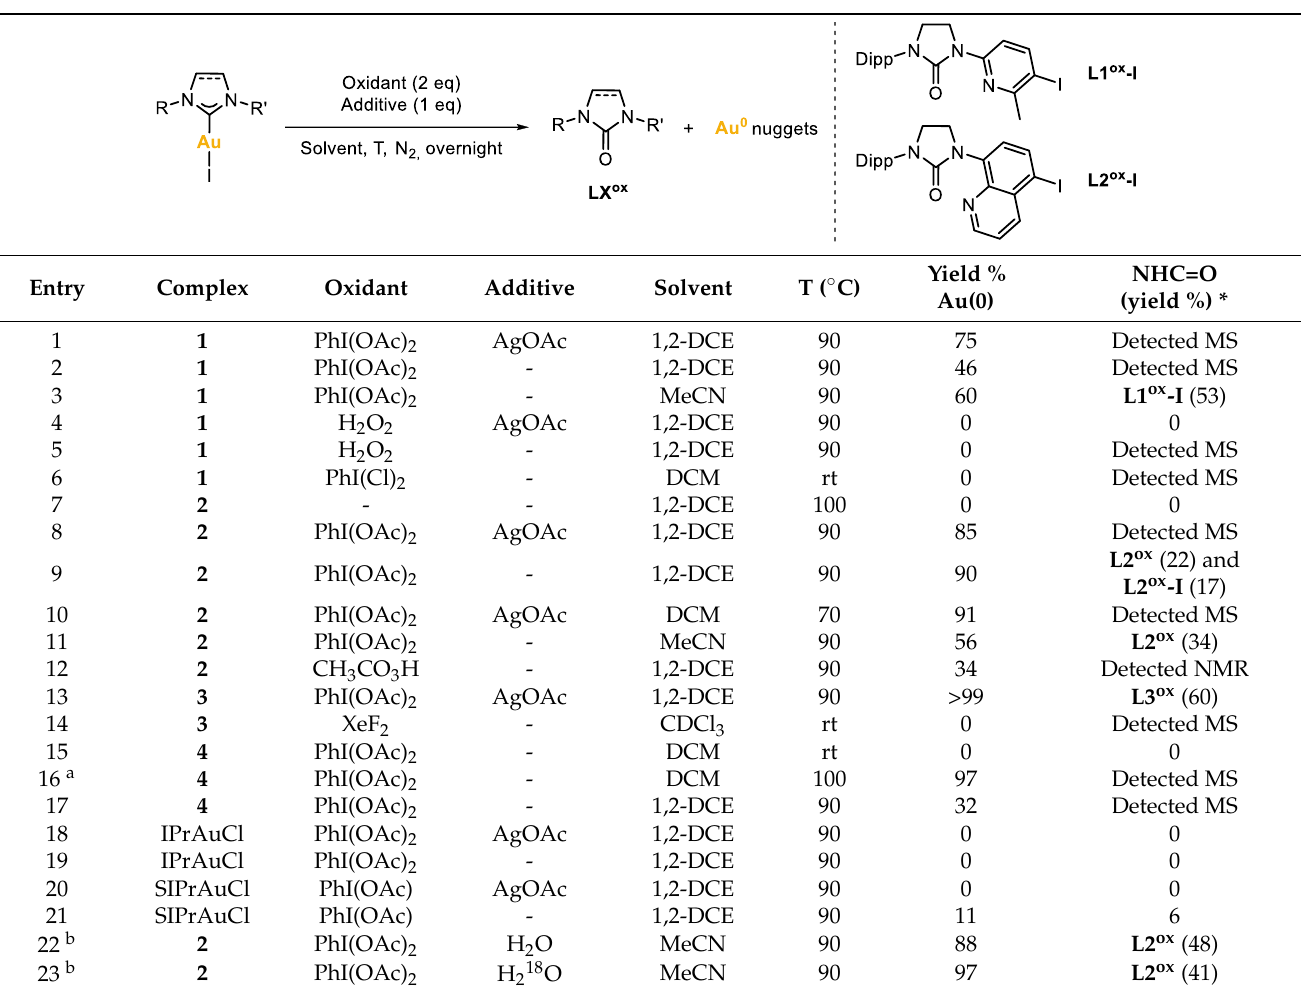
Table 1. Reactivity of gold(I) complexes towards the formation of gold(0) nuggets and azolones ( Lx ox ).